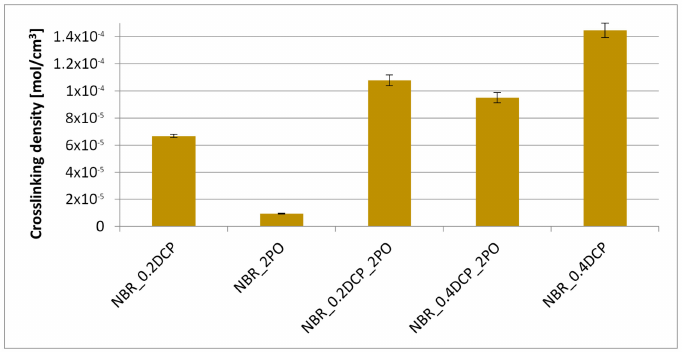
Figure 6. Influence of the modified resin addition on the crosslink density of NBR.